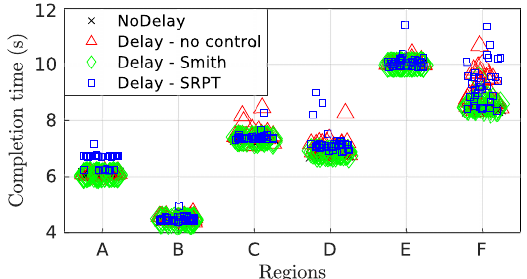
Figure 16. Scenario 1—Summary of performance indices.